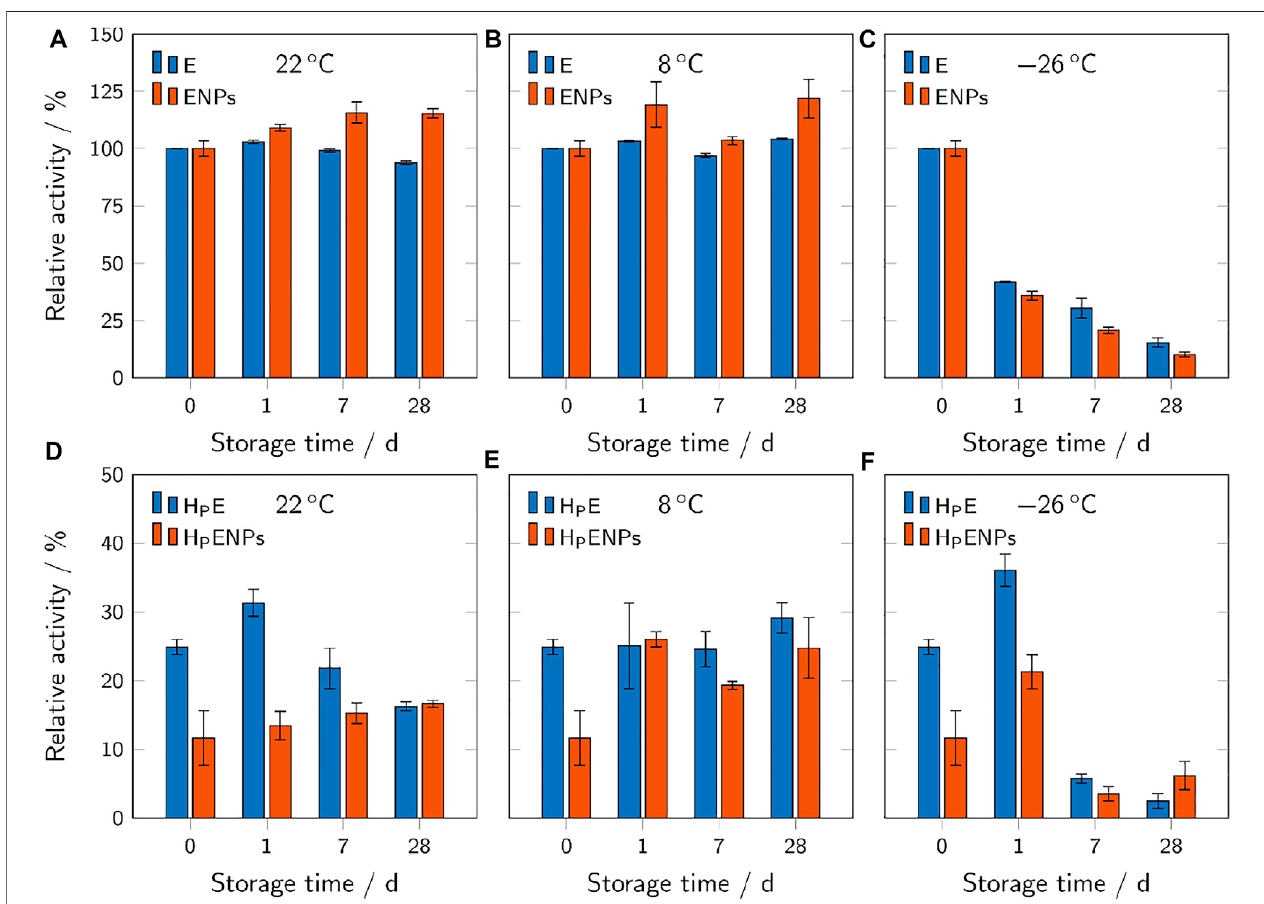
FIGURE 7 | Relative activities of free ENPs and free unbound enzyme (A – C) , compared to hydrogel microparticles containing ENPs (H P ENPs) and free enzyme (H P E) (D – F). The samples were stored at different temperatures and for different durations. The relative activities refer to the respective unencapsulated samples before storage and are shown as mean values ± standard deviation ( n (cid:1)